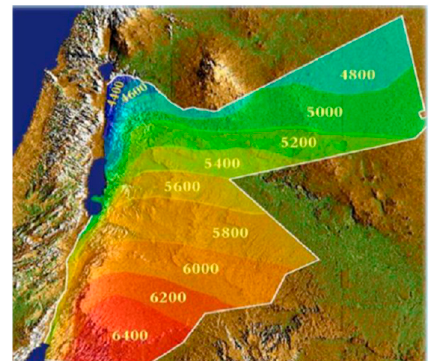
Figure 4. Jordan’s solar map (kWh/m 2 /day)